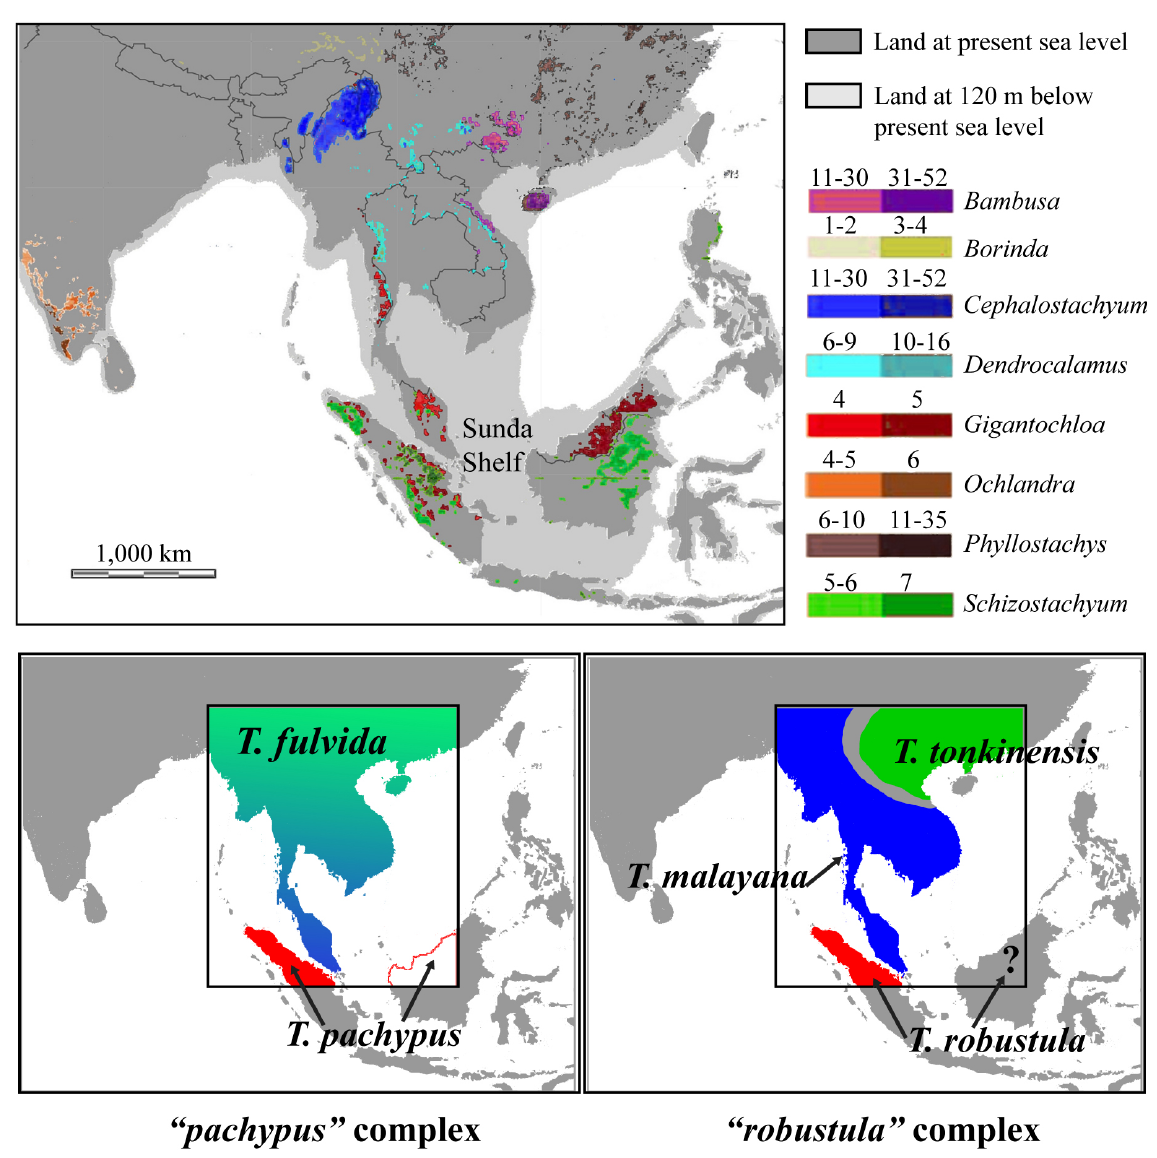
Fig. 6. Distribution and species richness for the eight genera of woody bamboo forests currently found in Asia (adapted and modified from Bystriakova et al. 2003b) and putative geographic range areas of the species of Tylonycteris . During glacial periods of the Pleistocene, the highlighted biogeographic regions may have acted as bamboo refugia for Tylonycteris spp. Moreover, sea level falls (at around 120 m below present) exposed land bridges, such as the entire Sunda Shelf (adapted from Voris 2000), connecting the islands to the